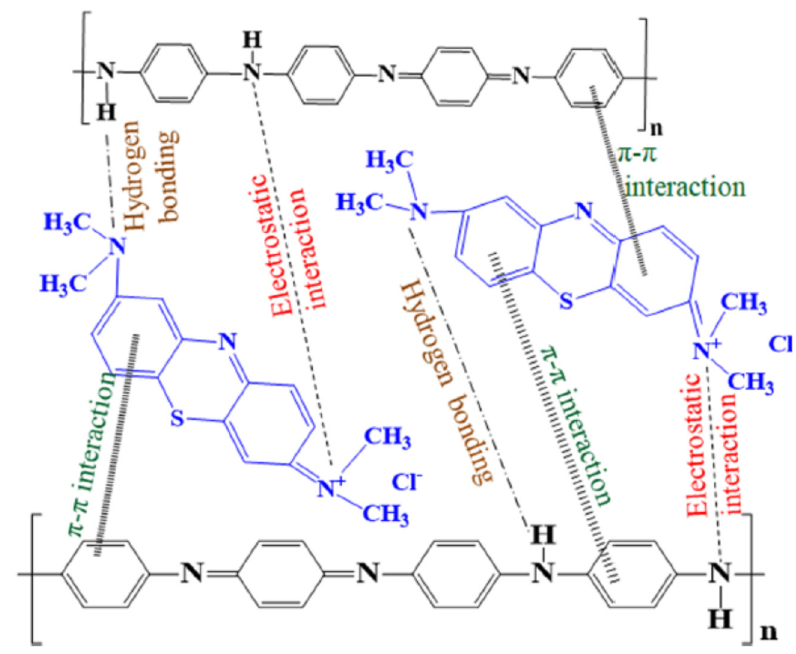
Figure 3. Different interactions proposed for the mechanism of methylene blue adsorption on polyaniline. Reprinted with permission from Ref. [57]. Copyright 2019 Springer Nature.